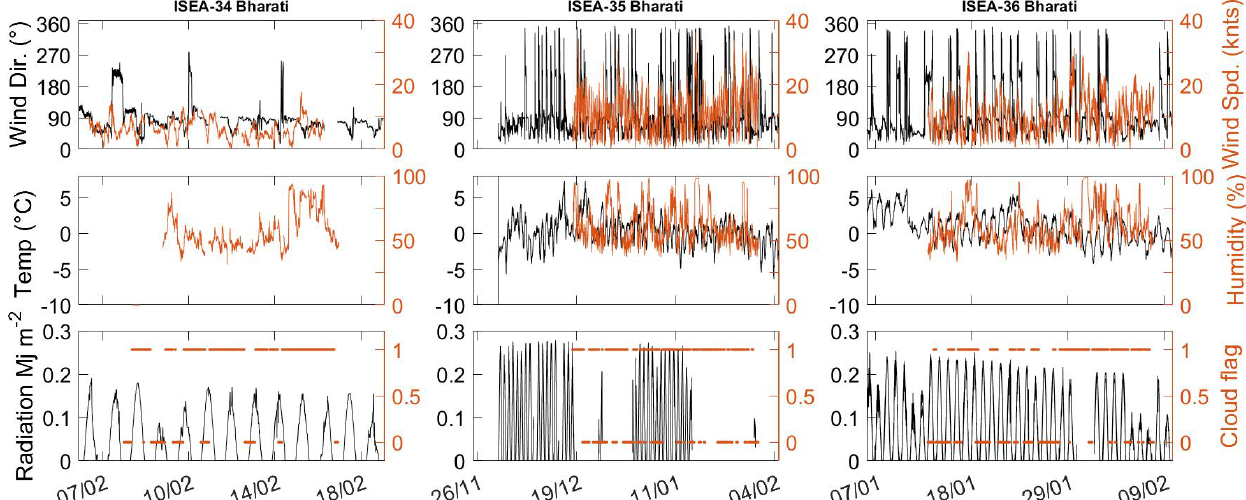
Figure 3. Observations of different meteorological parameters that were measured during the various summer campaigns are shown here. The top panels show the wind direction and speed, the middle panels show the temperature and humidity, and the bottom panels show the radiation and cloudiness (1 is defined as 30% cloudy skies and above). Observations of these parameters were not made during the 34th ISEA at Maitri, and the gaps indicate instrumental or observational issues. The data had a time resolution of